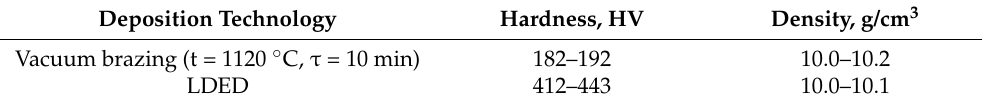
Table 6. Hardness and density depending on the Mo deposition technology.